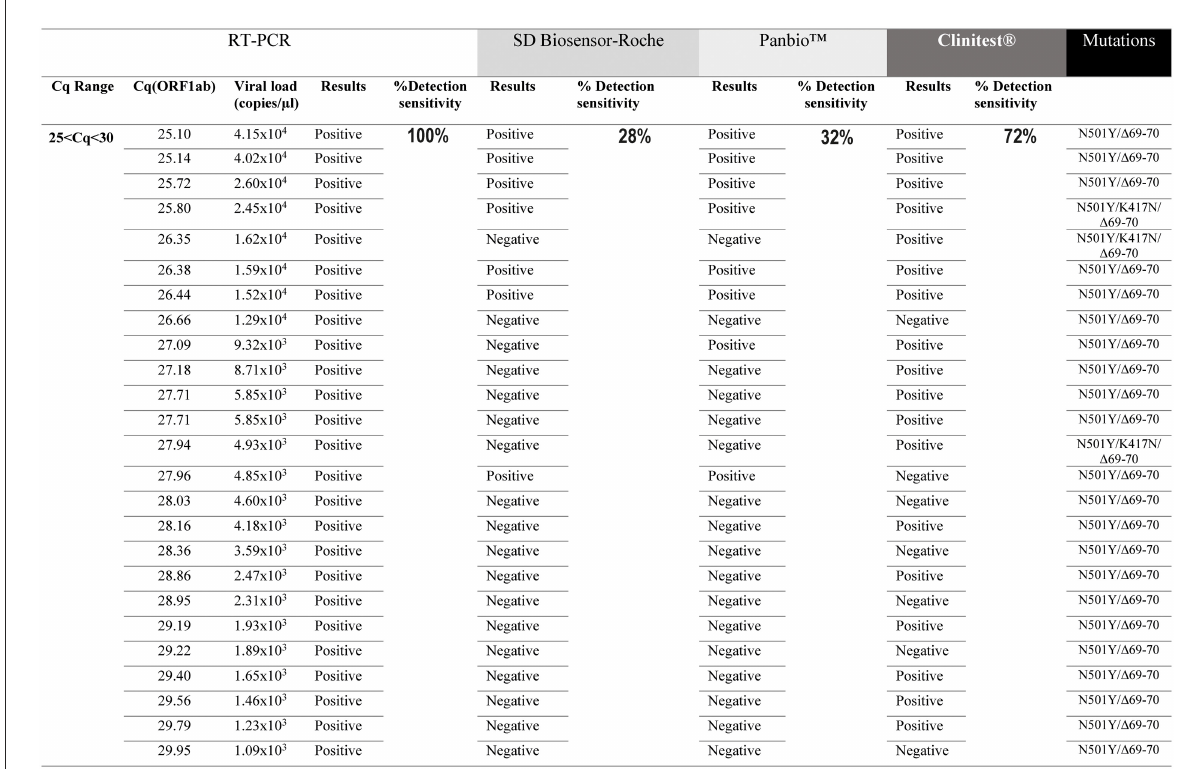
Table 1. All samples were positive for RT-PCR in both ranges of